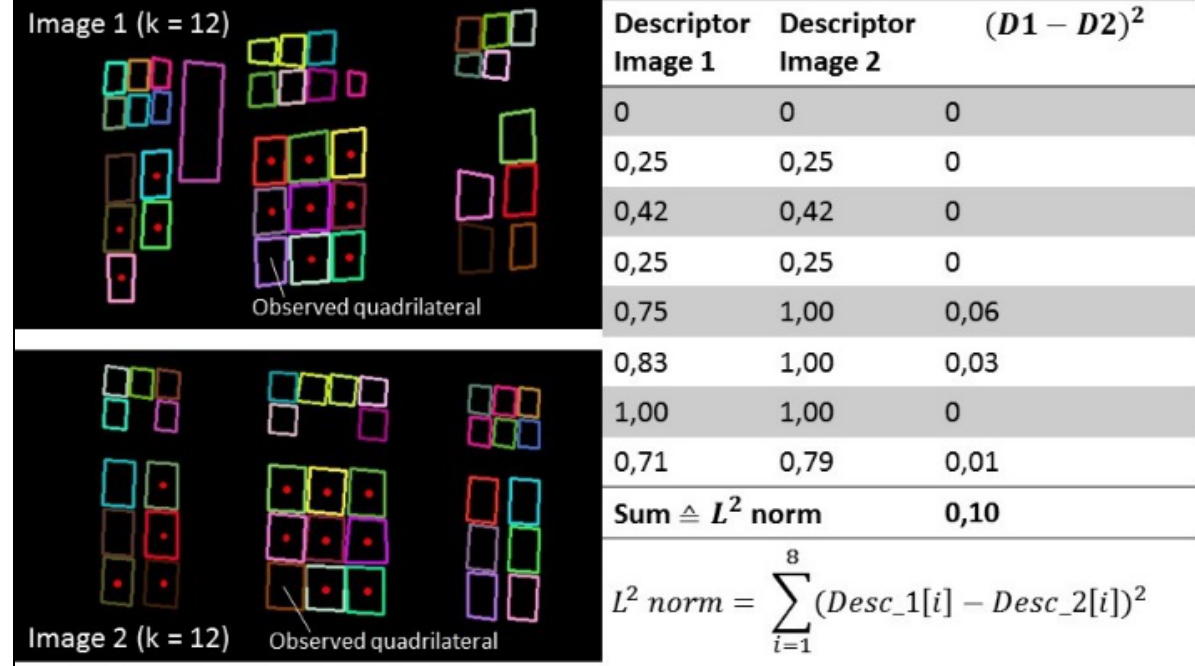
Figure 6. Two homologue quadrilaterals in two images and their calculated neighbourhood for k=12 (marked with red dots). Descriptor values are calculated for the two quadrilaterals and if the L 2 norm is low the descriptors and consequently the quadrilaterals are matched like in this